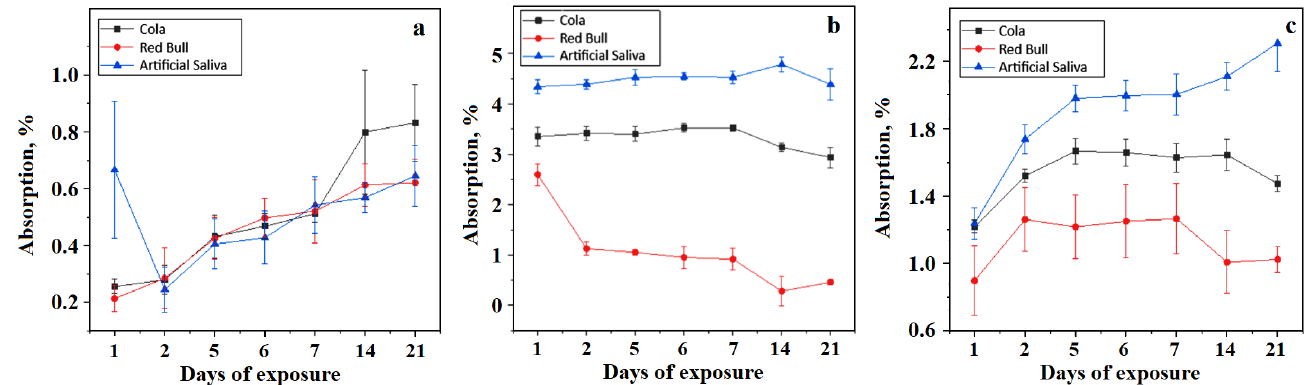
Figure 2. Absorption curveresults for the tested orthodontic cements: ( a ) BracePaste, ( b ) Fuji Or- tho, and ( c ) Transbond. and ( c )